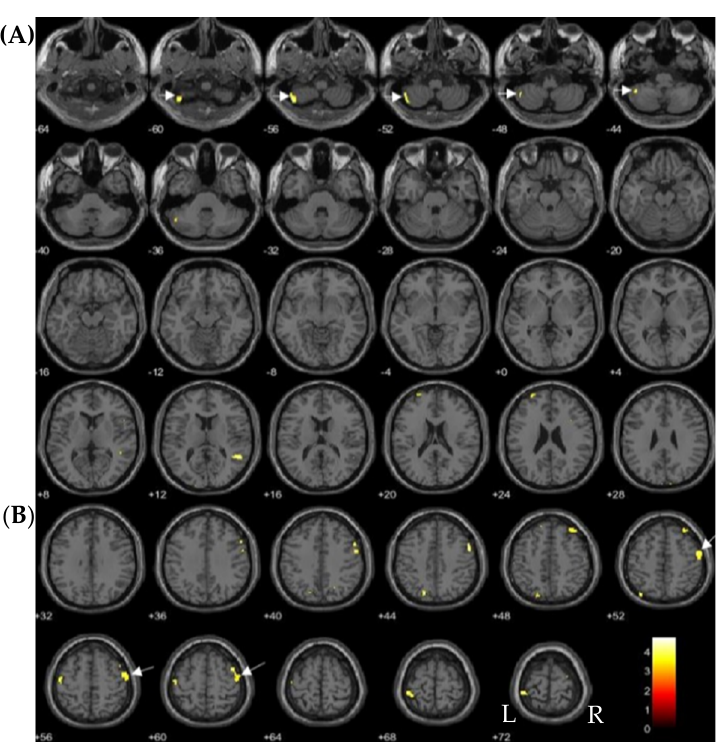
Figure 3. Brain regions positively correlated with 1,2,3,4,7,8-HexaCDD (FDR-corrected at p < 0.05) are indicated by yellow color and arrows on axial MRI. ( A ) shows the correlations in the left cerebellum lobule VII (arrows) and ( B ) shows those in the right middle frontal gyrus (arrows). L and R indicate the left and right sides of the hemispheres, respectively. Each value below each brain slice indicates each value in MNI z-coordinates.